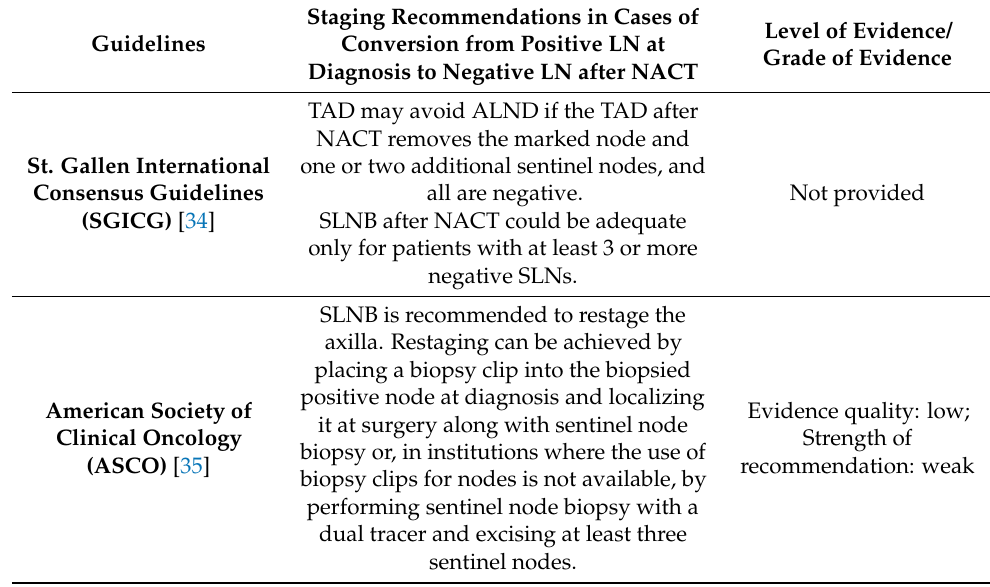
Table 2. Current recommendations of the main guidelines in patients with lymph node metastasis at the time of diagnosis down-staged to negative-node on clinical and ultrasound examination after neoadjuvant chemotherapy